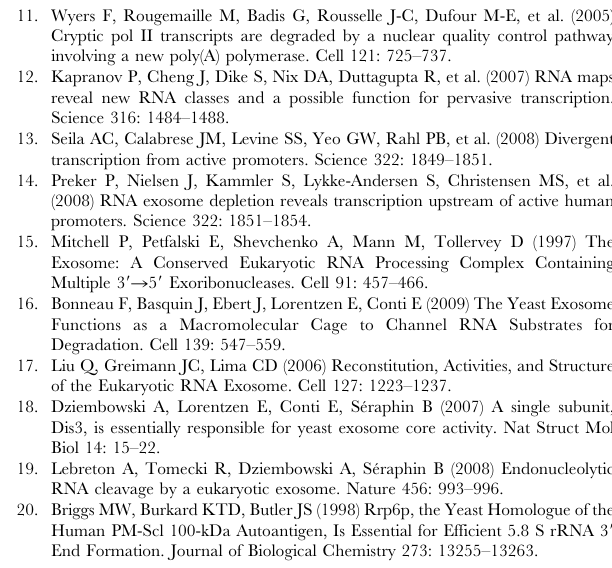
Table S2 Summary of smRNA sequence reads in the libraries of